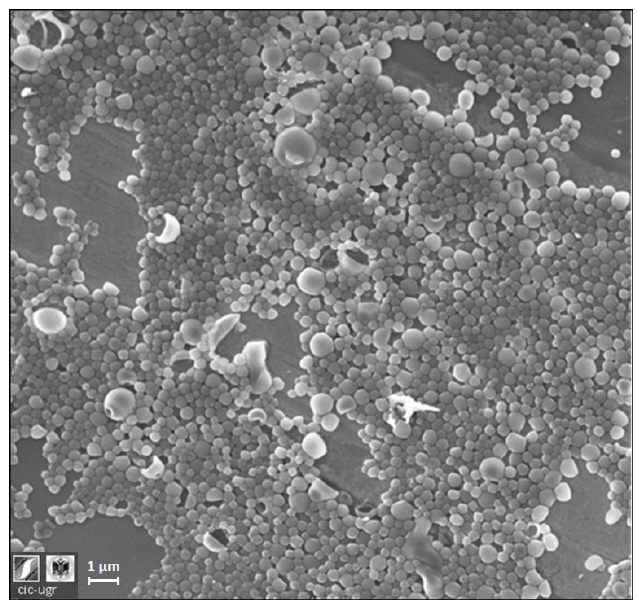
Figure 2. Figure 2. Scanning electron microscopy (SEM) micrograph of rhBMP-2-loaded nanoparticles (NP- BMP2).